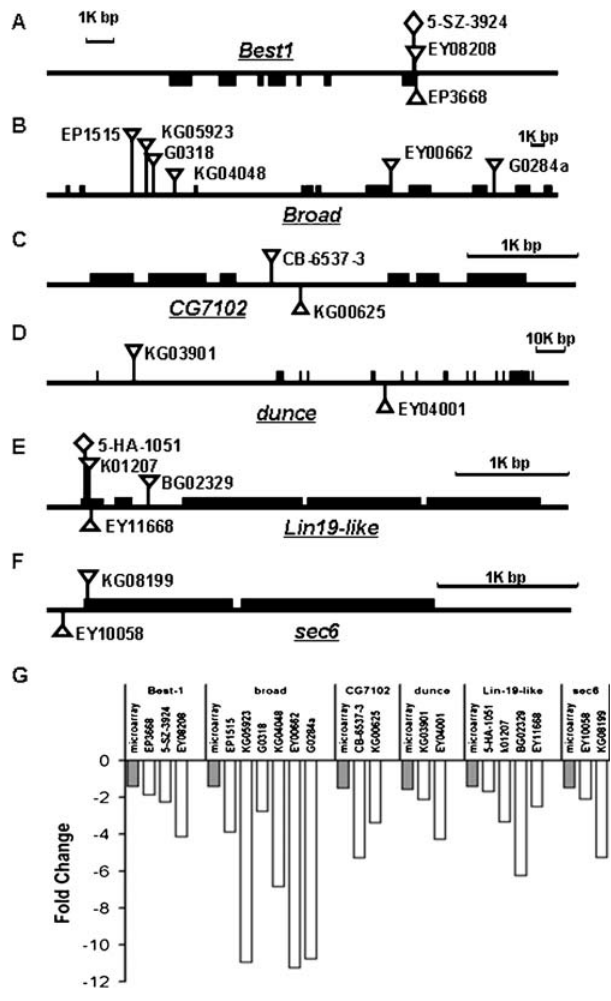
Figure 5. Alteration of target gene expression by P-element insertion. (A–F): Genomic localization of P -element insertions within or around gene Best1 , broad , CG7102 , dunce , lin19 and sec6 . (G): Effect of P -element insertion on target gene expression was determined by sq- RT-PCR. Each open-bar represents the mean value of sqRT-PCR of a P - element allele for the target gene.